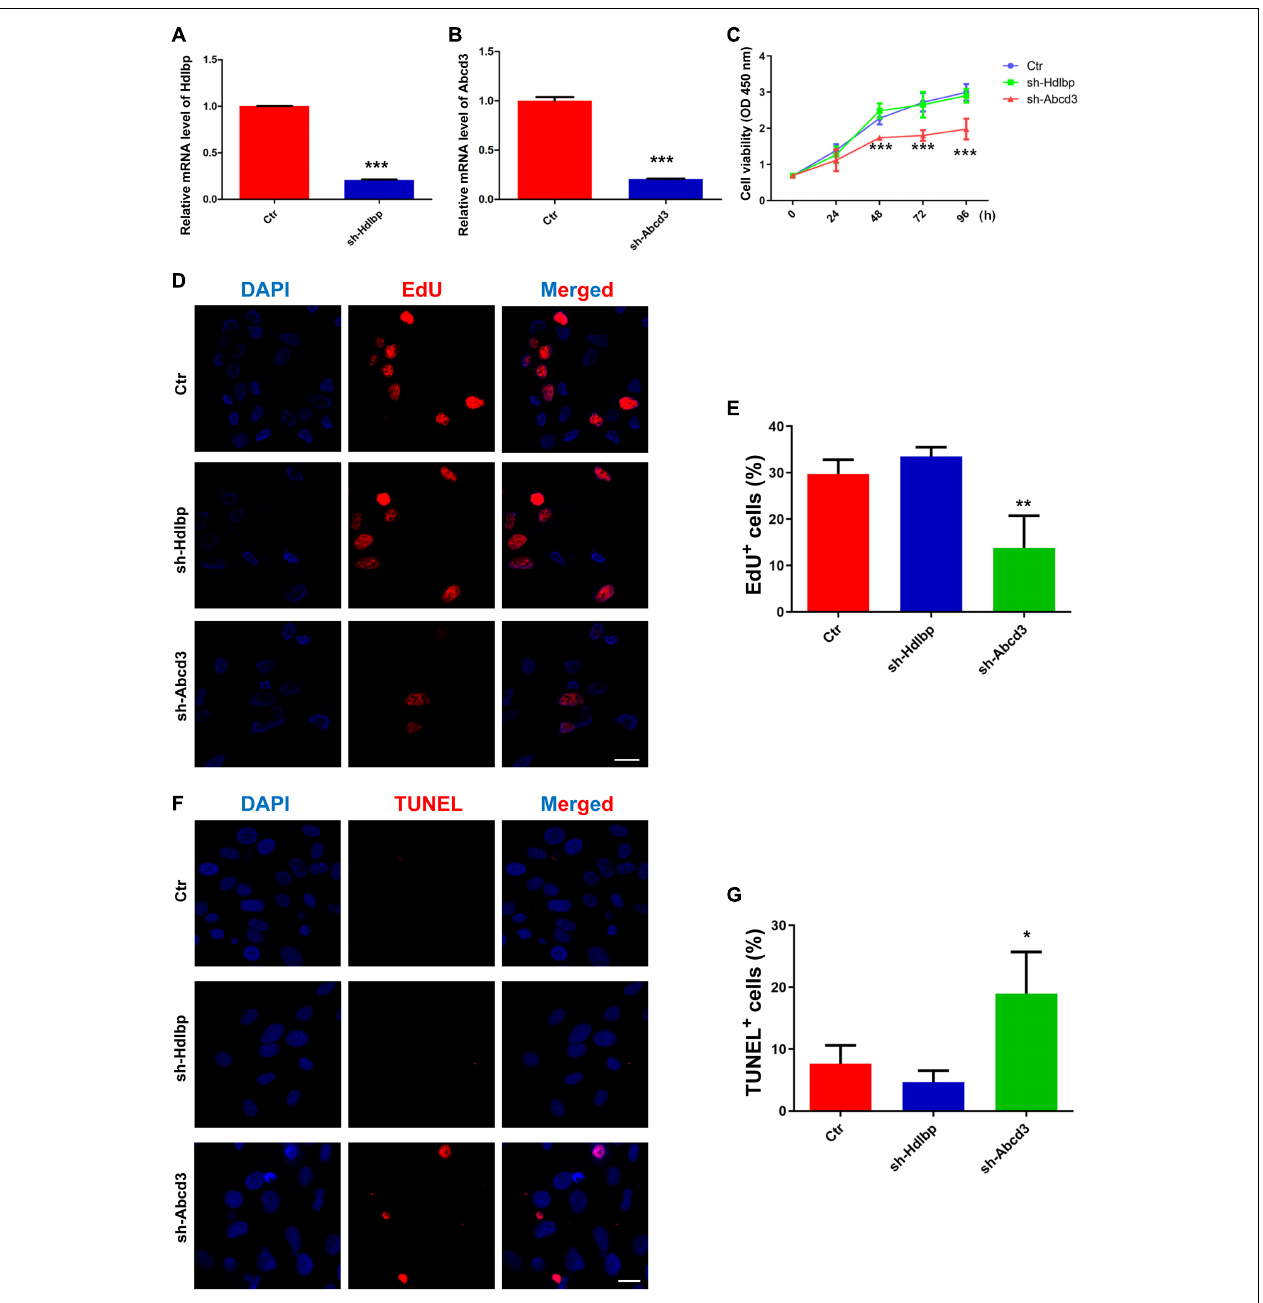
FIGURE 4 | The effects of HDLBP/ABCD3 on BM-MSC proliferation and apoptosis in vitro . (A,B) Relative mRNA levels of Hdlbp and Abcd3 were significantly reduced by each respective shRNA for 48 h, n = 3. (C) CCK-8 assays were used to determine the proliferative capacity of HDLBP- and ABCD3-depleted BM-MSCs, n = 6. (D,E) EdU staining was conducted to evaluate EdU-positive BM-MSCs in both HDLBP- and ABCD3-depleted groups compared with the negative control after treatment for 48 h. The EdU-positive cells are labeled in red, and cell nuclei are labeled in blue, n = 3. (F,G) TUNEL assays were performed to determine BM-MSC apoptosis after HDLBP or ABCD3 suppression for 48 h. The TUNEL-positive cells are labeled in red, and cell nuclei are labeled in blue, n = 3. Scale bar, 20 µ m. * p < 0.05; ** p < 0.01; *** p < 0.001. For (A,B) , Student’s t -test; for (C,E,G) , one-way ANOVA.